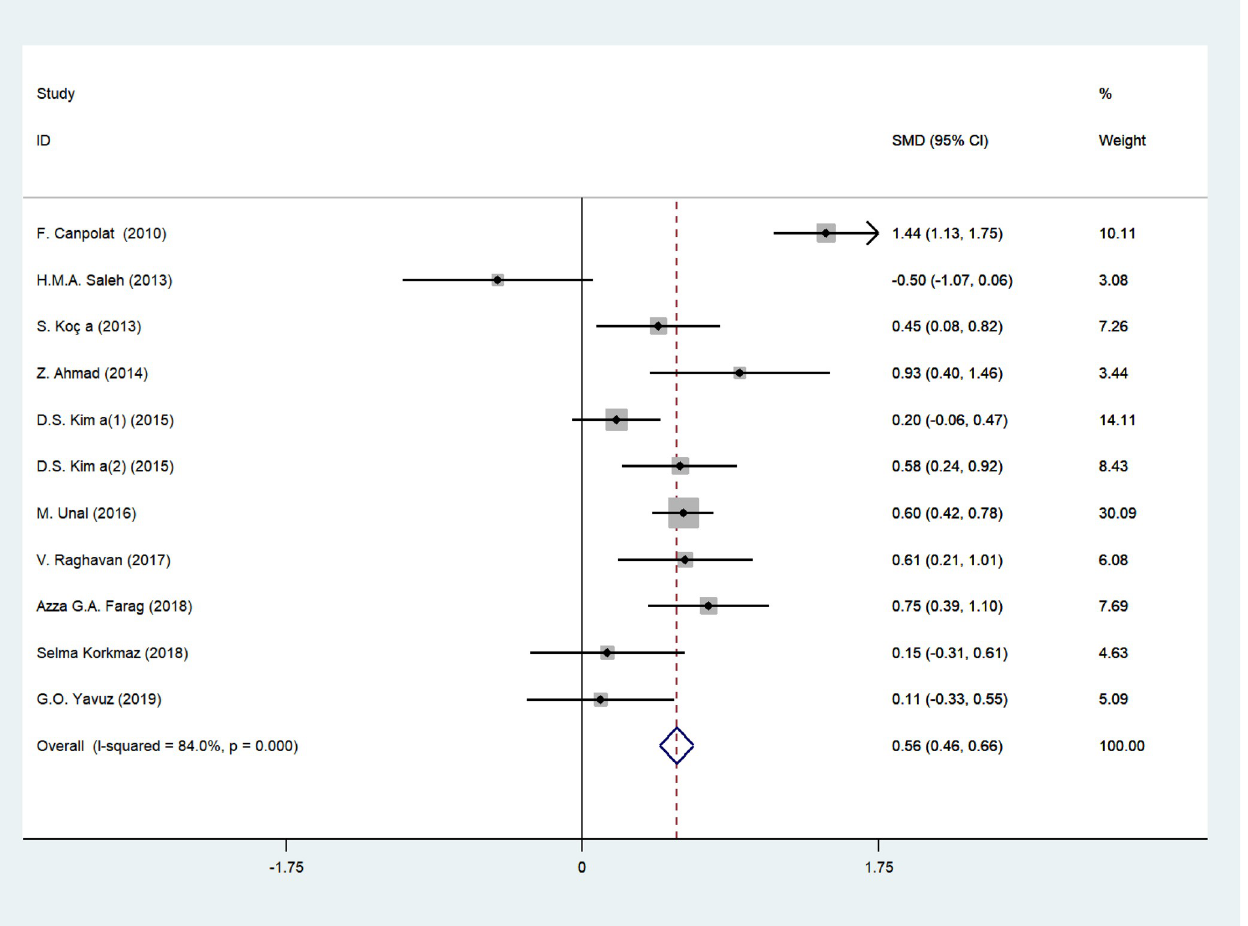
Fig 2. Forest plot of MPV values and the presence of psoriasis.